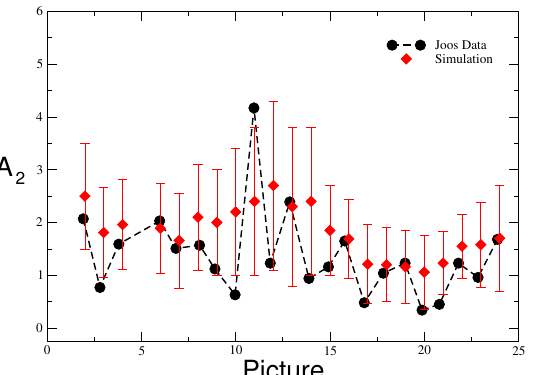
Figure 8. Joos’ second-harmonic amplitudes (in units of 10 − 3 (black dots)) are now compared with a simulation where one averages ten measurements that were performed on 10 consecutive days at the same sidereal times as those of Joos’ observations (red diamonds). The changes in the averages observed by varying the parameters of the simulation were summarized into a central value and a symmetric error. The figure is taken from